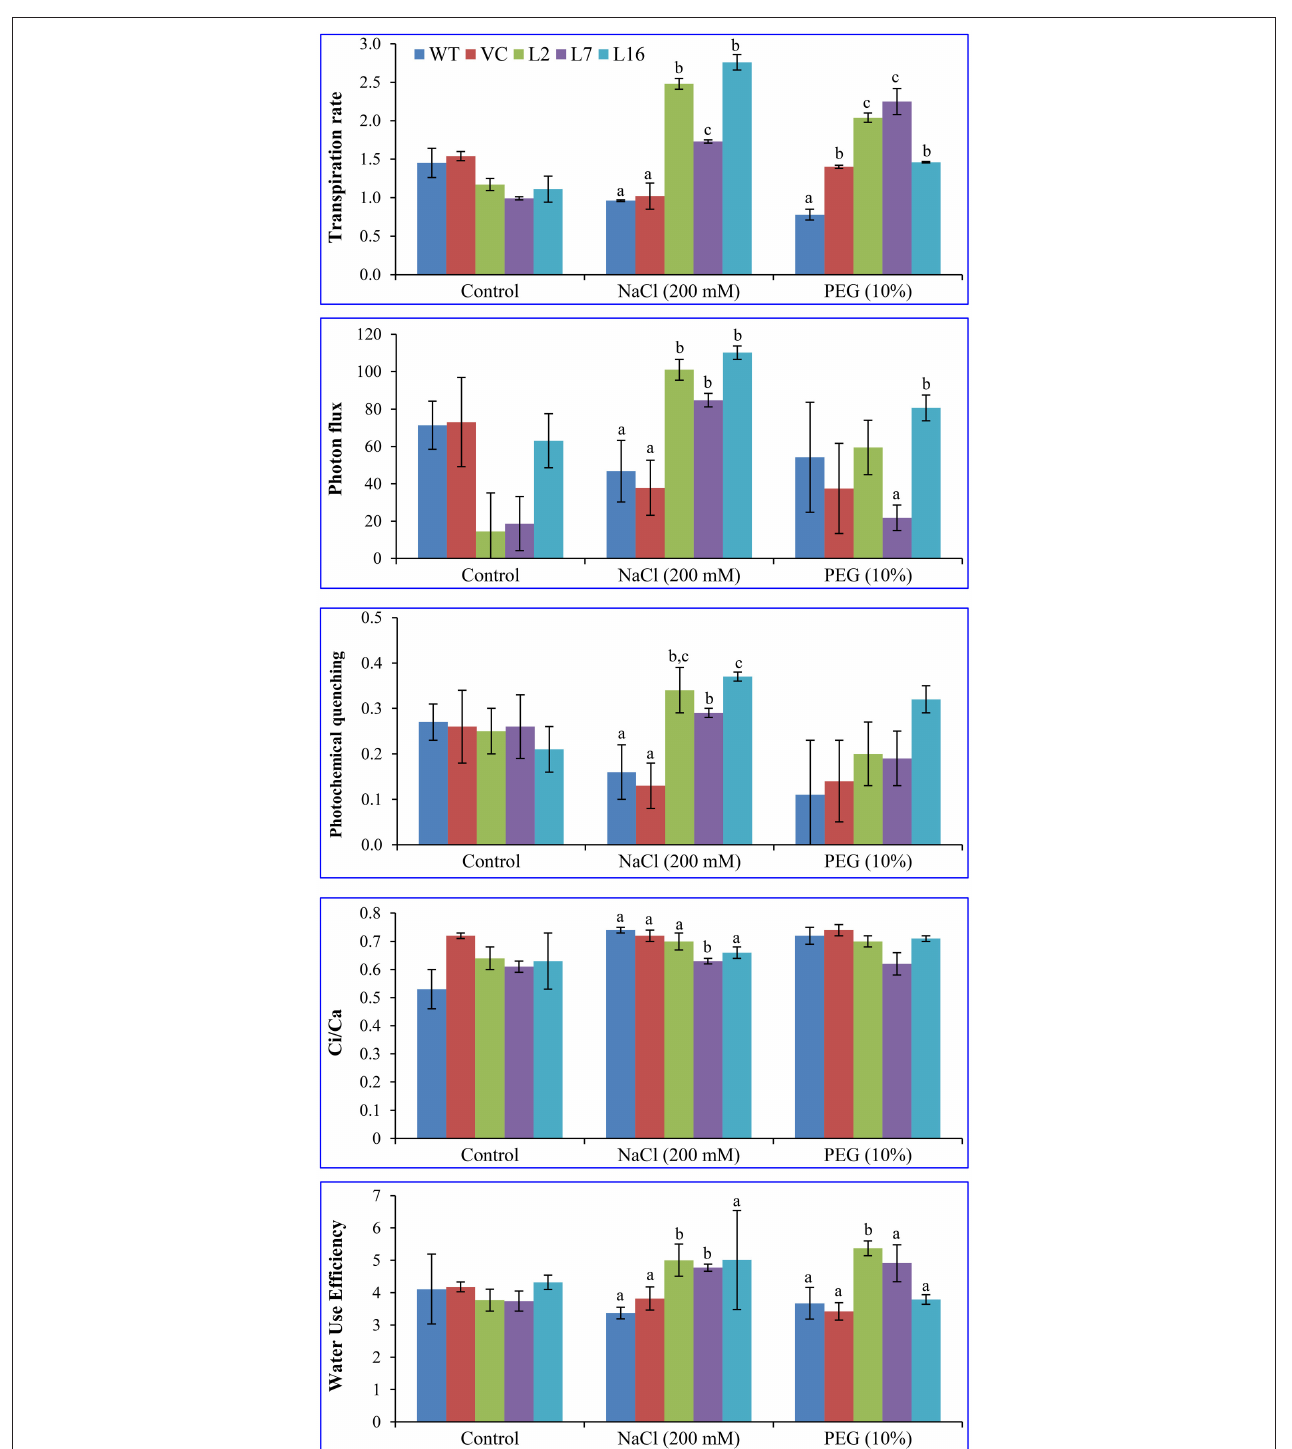
FIGURE 8 | Quantitative analysis of the physiological status of transgenic lines. Transpiration rate, photon flux, photochemical quenching, Ci/Ca ratio, and water use efficiency of WT, VC, and transgenic lines (L2, L7, and L16) were measured under salinity and osmotic stress condition. Bars represent means ± SE and values with different letters are significant at P <